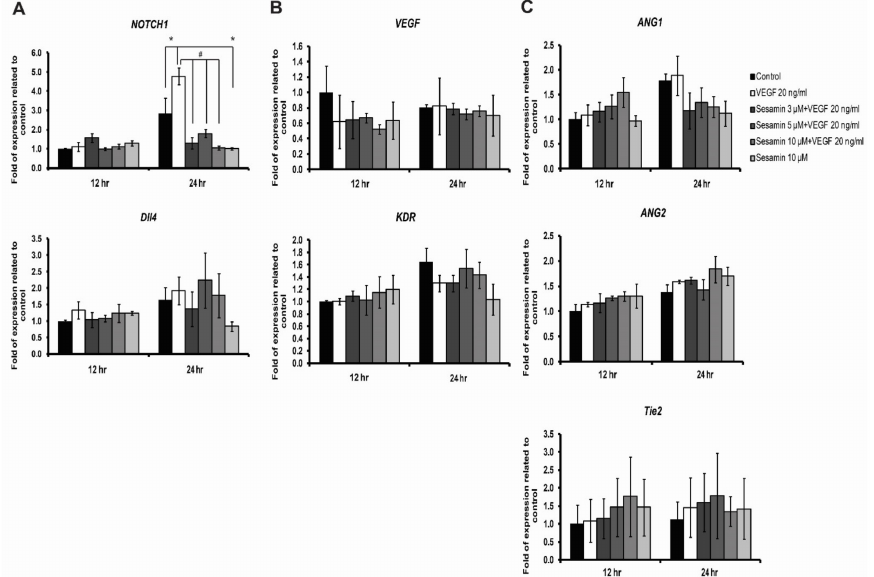
Figure 5. The effect of sesamin on ( A ) NOTCH1 and Dll4 gene expression, ( B ) VEGFA and KDR gene expression and ( C ) ANG1, ANG2, and Tie2 gene expression in human endothelial cell line, EA.hy926. Cells were treated with 20 ng/mL VEGFA alone or cotreated with VEGFA and various concentrations of sesamin (3, 5, and 10 µ M) for 12 and 24 h and the relative mRNA expression of the specific genes compared to that of GAPDH was determined by real time RT-PCR. The data are expressed as the mean ± SEM from three independent experiments with technical triplicates in each. * indicates a significant difference compared with untreated control at p -value less than 0.05. # indicates a significant difference compared with VEGFA treatment at p -value less than 0.05.